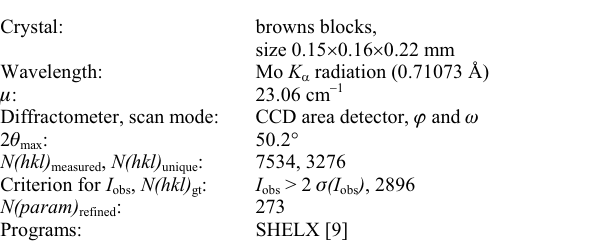
Table 1. Data collection and handling.